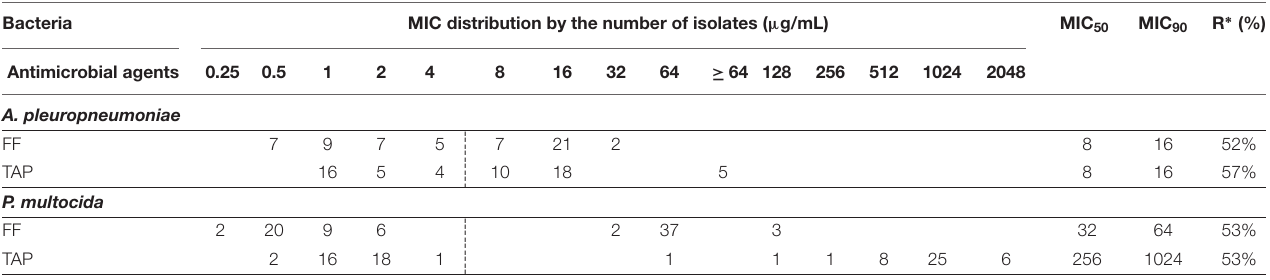
TABLE 1 | Distribution of minimum inhibitory concentration (MIC) value for FF and TAP tested against A. pleuropneumoniae ( n = 58) and P. multocida ( n = 79) isolated from swine. Bacteria MIC distribution by the number of isolates ( µ g/mL) MIC 50 Antimicrobial